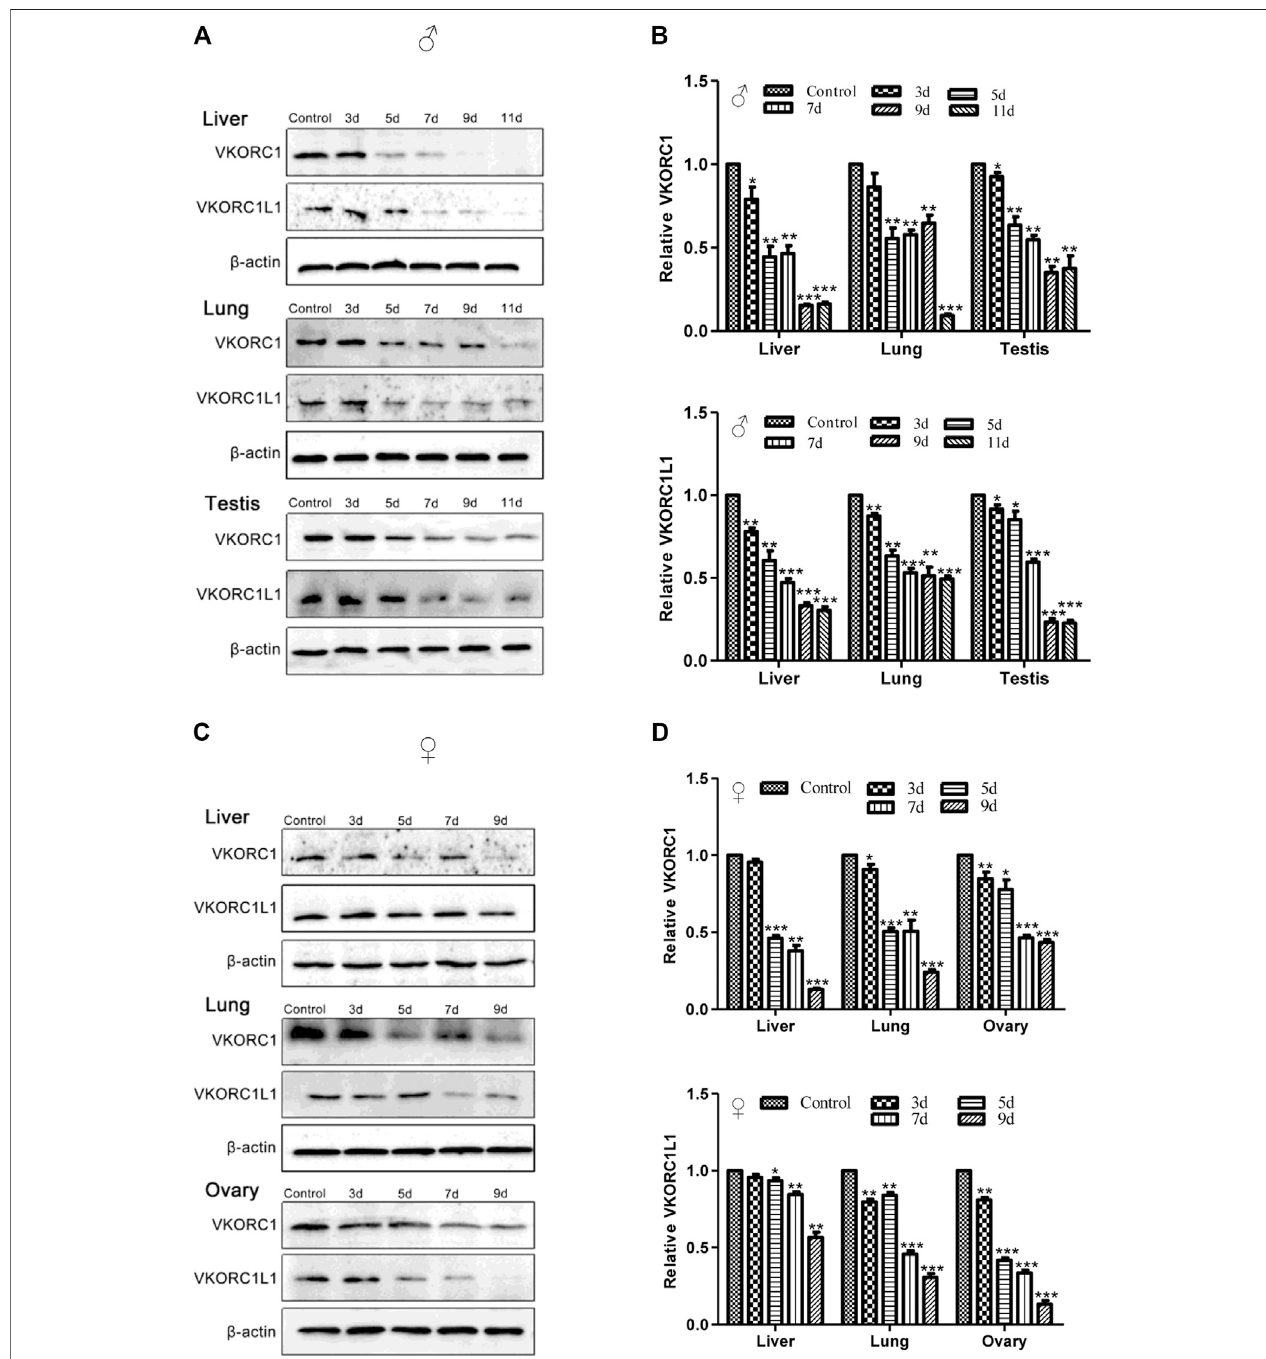
FIGURE 3 | The expression of VKORC1/VKORC1L1 in the tissues of rats treated with Na-DHA. The western blot analysis was performed for the VKORC1/ VKORC1L1 expression in tissues of rats treated by 200 mg/kg Na-DHA. A and B for male rats, (C) and (D) for females. (A) and (C) , the western blot bands of VKORC1, VKORC1L1indifferenttissuesofrats;BandD,statisticalanalysiscolumnofthebandsgreyvaluesnormalizedwiththatinthecontroloverthreeparallelexperimentswith triplet repeats. * p < 0.05, ** p < 0.01, *** p < 0.001, compared to the normal control group.